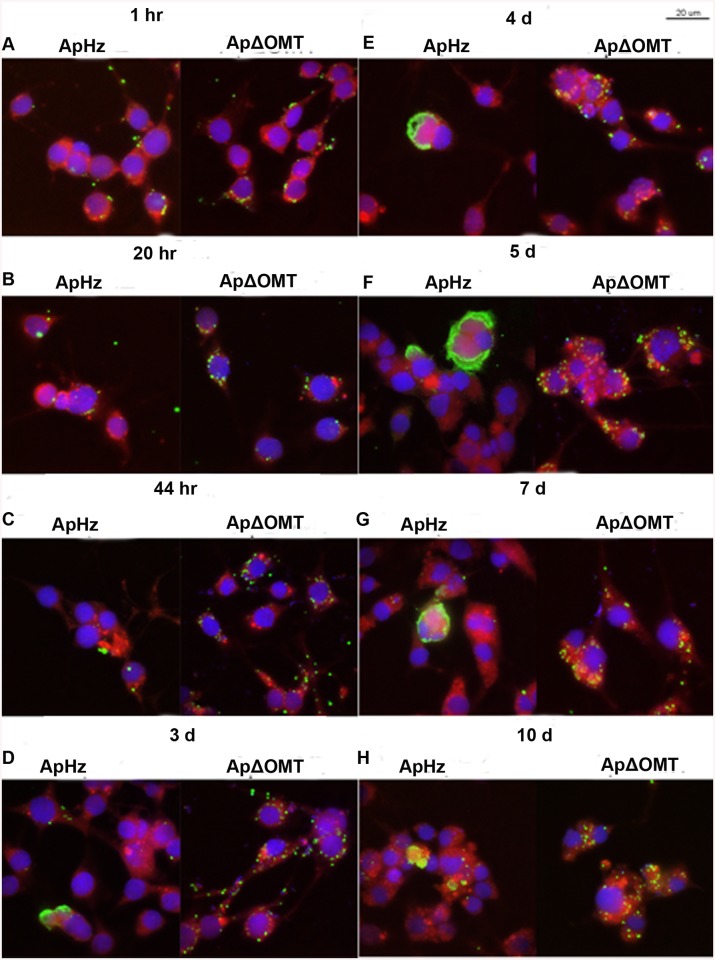
Time course of wild type and ΔOMT A. phagocytophilum development within ISE6 cellsHost cell-free wild-type (ApHZ) and mutant (ApΔOMT) A. phagocytophilum were harvested from HL-60 cells and incubated with ISE6 cells expressing mCherryLifeAct (red, to provide contrast) grown in MatTek chambers for 1 hr at a high MOI (100–300 bacteria/cell) to maximal internalization that permitted observation of phenotypic defects in the ΔOMT which was not possible using a stringent invasion assay. Subsequently, unbound bacteria were washed away and samples were taken at the indicated times post infection. Panels for each sampling time show wild-type bacteria at left, and mutant at right. A) 1 hr, B) 20 hr, C) 44 hr, D) 3 days, E) 4 days, F) 5 days, G) 7 days, and H) 10 days. Bacteria were labeled with FITC (green), cell nuclei were labeled with DAPI (blue), and samples were viewed by confocal microscopy to compare development of bacteria within ISE6 cells. Saturated binding allowed sufficient numbers of ApΔOMT to be internalized (1 hr panels) so that their development could be visually tracked for 10 days. From 44 hr through 10 days, small to very large morulae developed in ApHZ, while the ΔOMT persisted as individual bacteria within the ISE6 cells and never formed morulae. The size bar represents 20 μm.